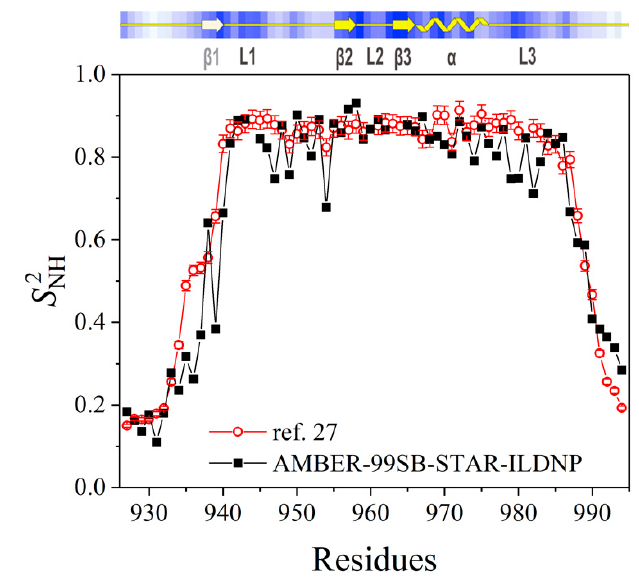
Figure 4. Comparison between the order parameter of the NH bond of the Arkadia RING 927–994 domain predicted by employing the AMBER-99SB-STAR-ILDNP molecular mechanic’s force field and NMR relaxation data [27]. The top plane indicates observations regarding the secondary structure as obtained from the previous NMR-based study [27].